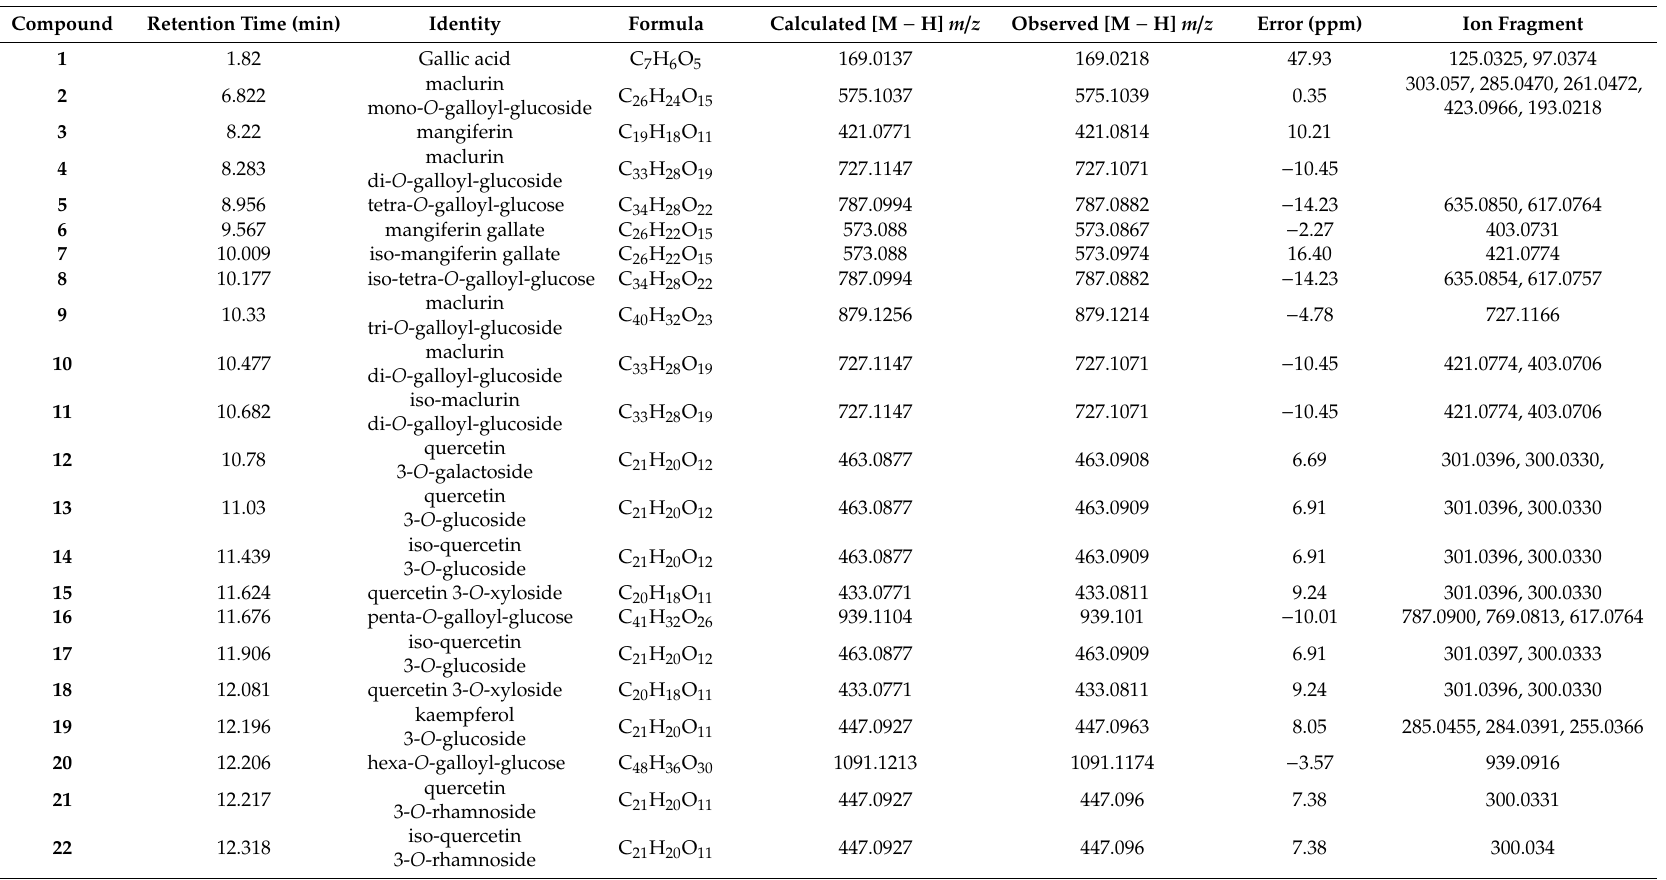
Table 4. Identification of polyphenolic compounds in Kensington Pride mango peel by UPLC-Q-TOF-HRMS n